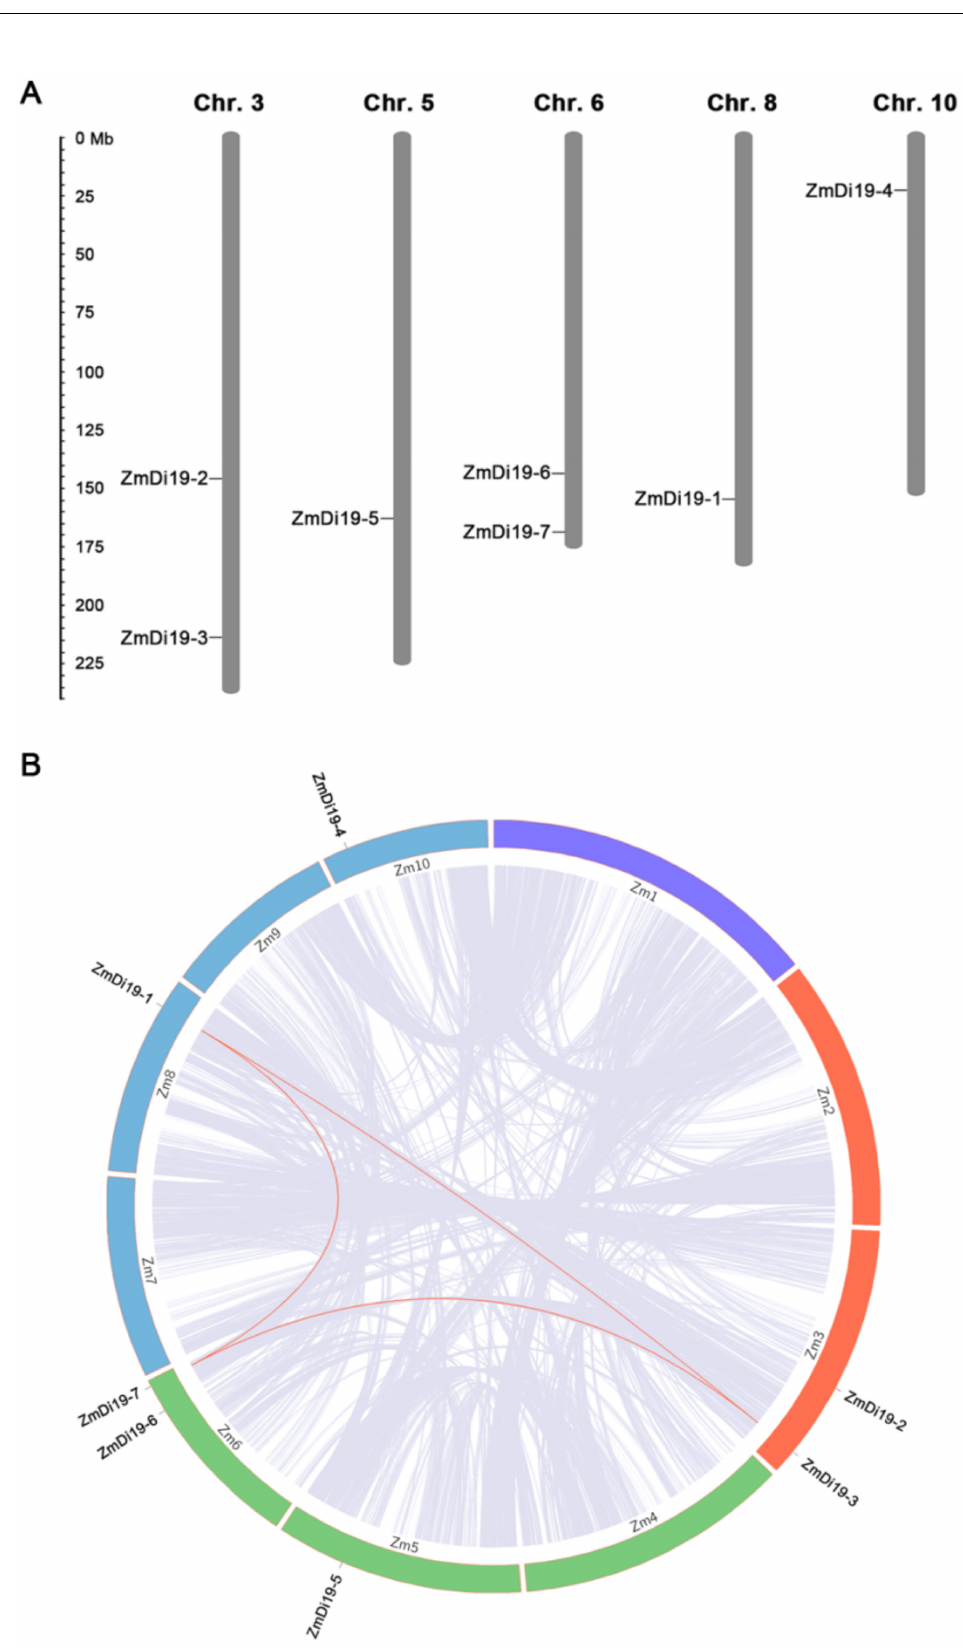
Figure 3. Chromosomal location and syntenic analysis of ZmDi19 genes. ( A ) Seven ZmDi19 genes located on the five of the 10 chromosomes. ( B ) Syntenic analysis among ZmDi19